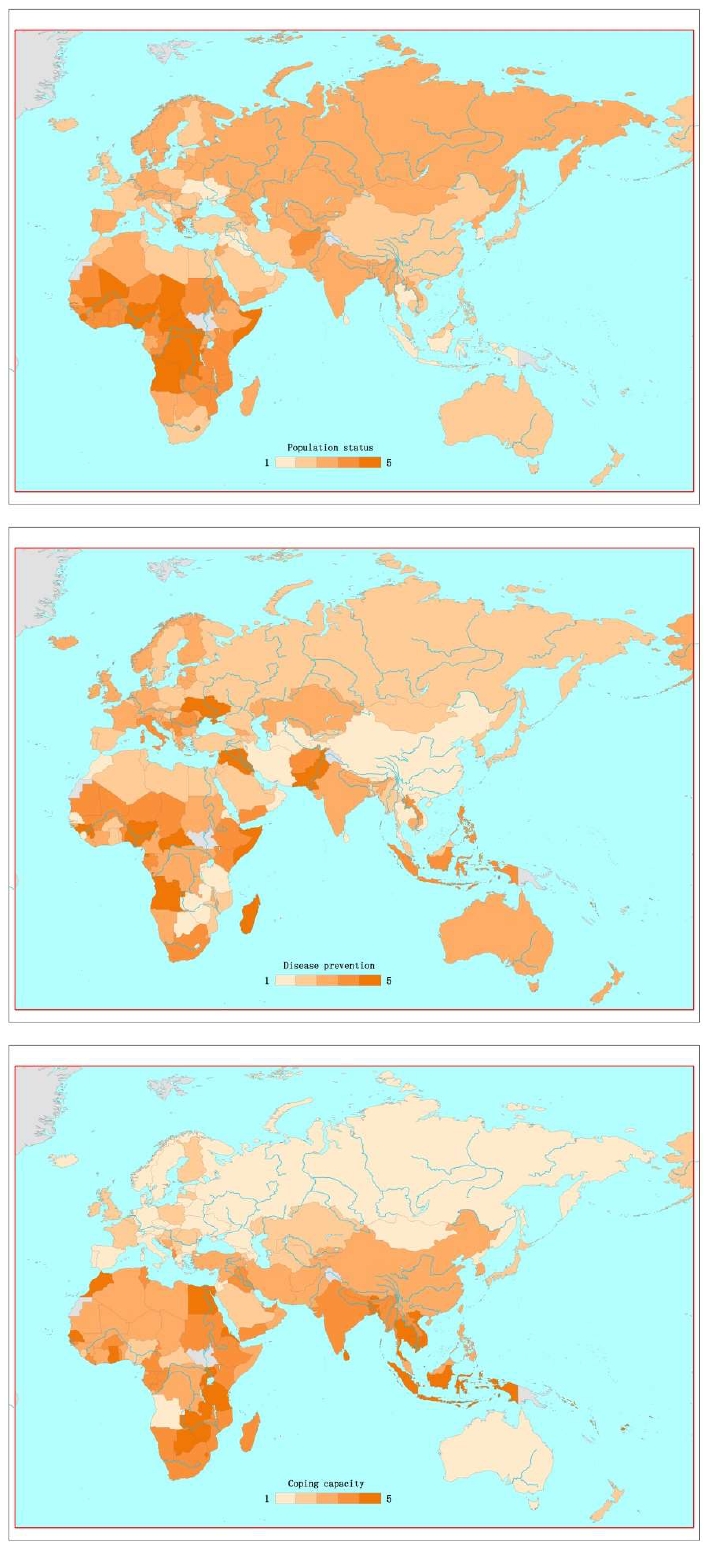
Figure 3. Factor scores of countries along the Belt and Road Initiative (BRI) region. Note: deeper color indicates a higher factor score and greater vulnerability.